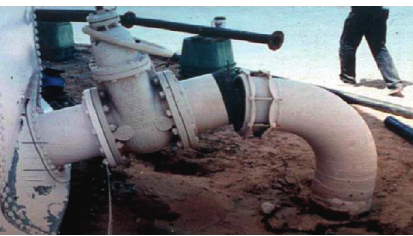
Figure 12: Cracks in the pipe connected to the storage (ALA 2002).